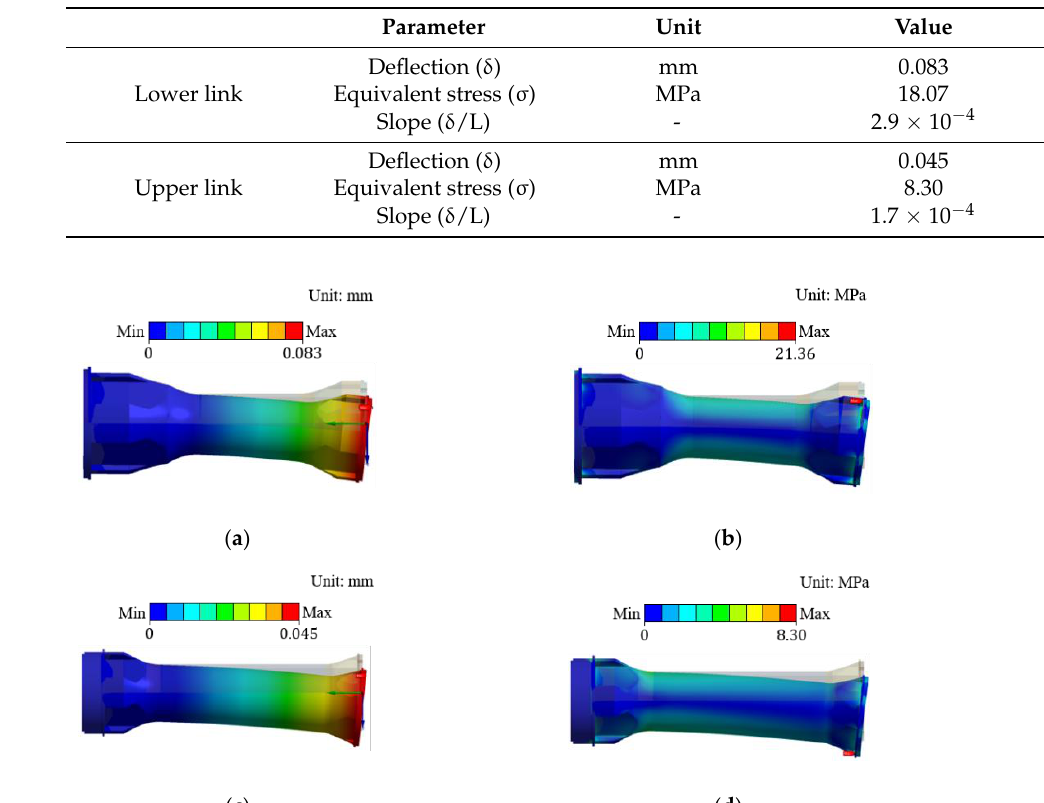
Table 2. Results of Links Stress Analysis.